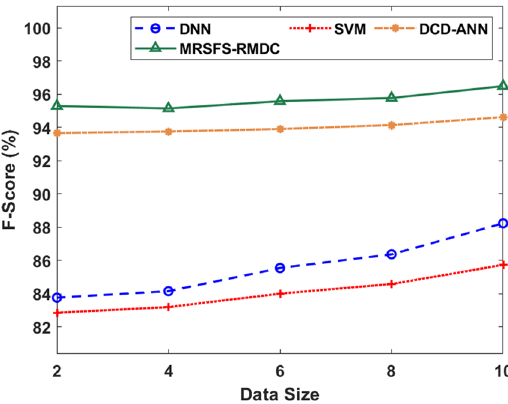
Figure 7: F - score analysis of MRSFS - RMDC model with distinct data